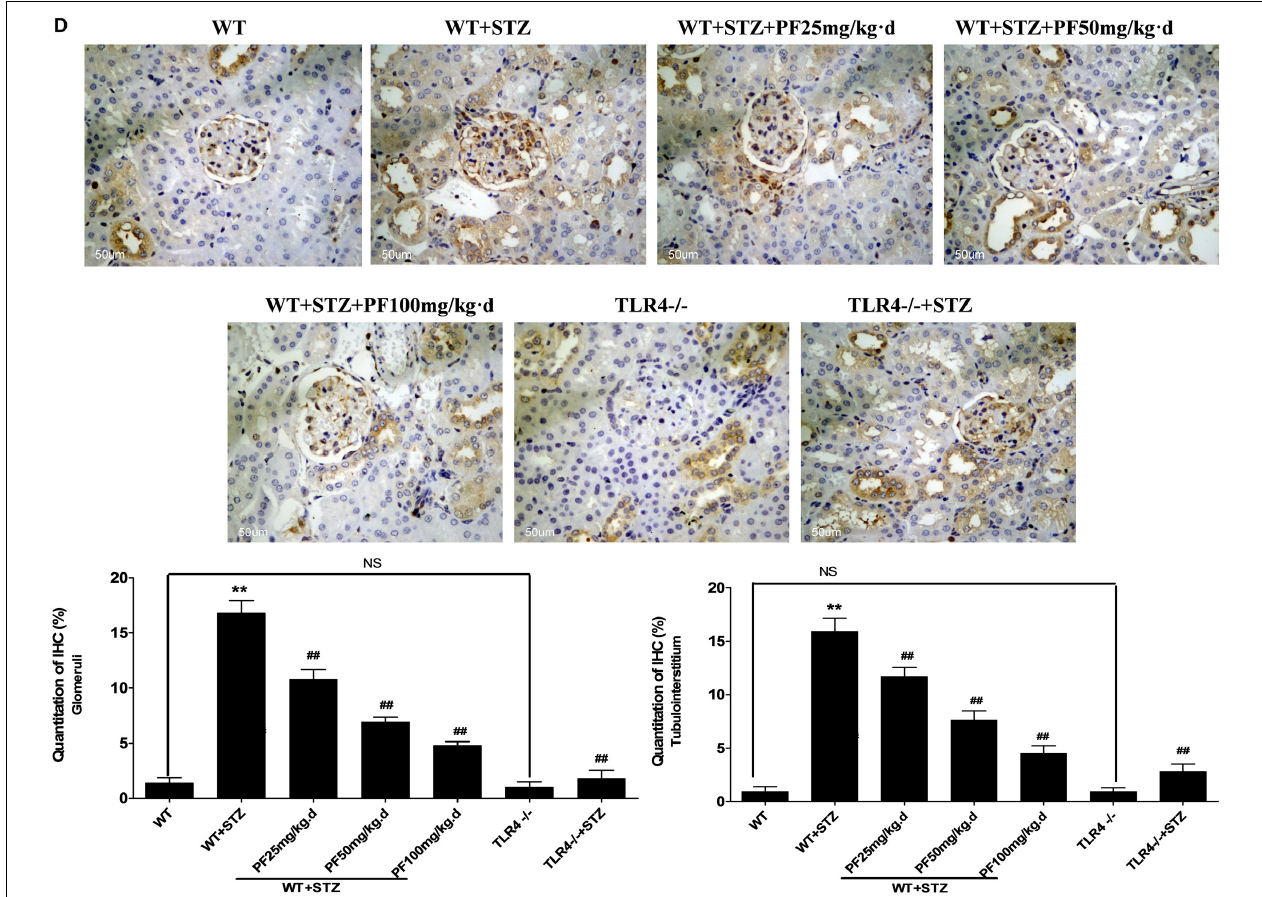
FIGURE 2 | PF treatment could alleviate the pathological manifestations of DN. (A) Histological observations of kidney sections stained with PAS. (B) Quantitation of CD68-positive cells, representing the recruitment of macrophages in the tissue. Macrophages were counted in randomly selected high-power (400 × ) fields. (C,D) Immunohistochemistry results evaluated as the average positive stained area percentage by ImagePro Plus Systems. The results are represented as the mean ± SD; n = 10 in each group. ∗ p < 0.05 and ∗∗ p < 0.01 vs. WT; # p < 0.05 and ## p < 0.01 vs. WT+STZ; NS, not